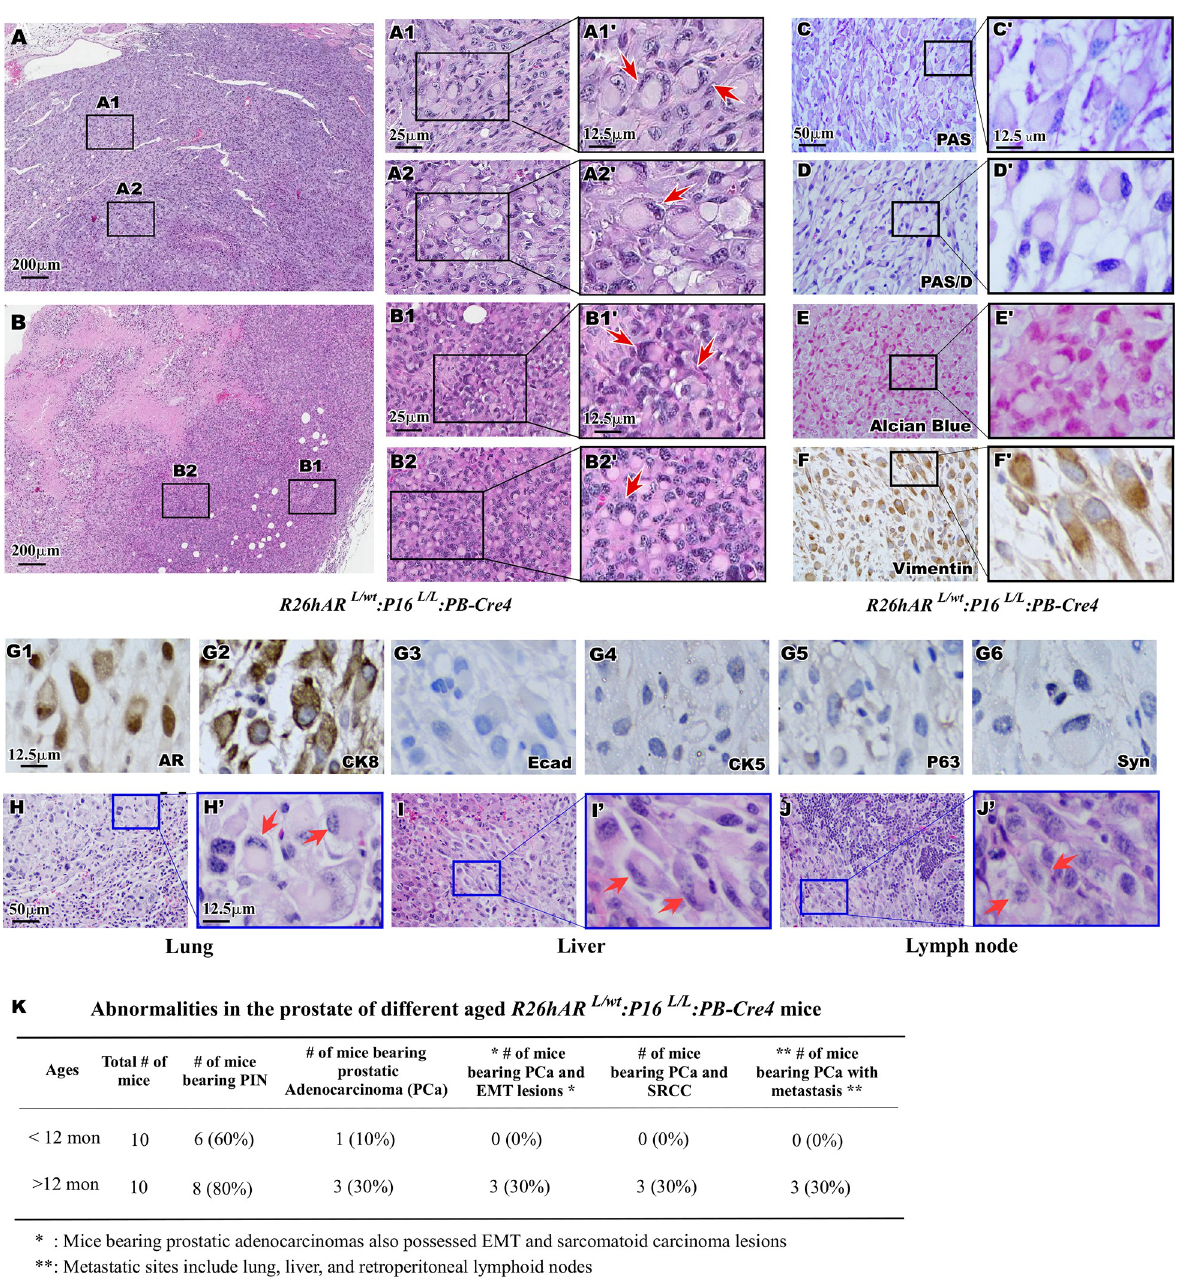
Fig 5. Histological and Immunochemical identification of signet ring cell carcinoma. (A-B) Representative image of the prostate signet ring cell carcinomas, SRCCs, in R26hAR L/wt : p16 L/L : PB-Cre4 mice. Scale bar = 200 μ m. A1-B2. Pathological characterization of typical morphological characteristics of SRCC was highlighted in two different tumor samples with magnified views (A1’- B2’). (C-F) Representative view is shown for PAS/PAS (C-D, magnified view C’-D’) staining, Alcian Blue staining (E, magnified view E’), and vimentin immunoreactivity (F, magnified view F’). Scale bar used was at 50 μ m and magnified views scale bar used was at 12.5 μ m. (G). Representative view of IHC images of adjacent prostate tissue sections of signet ring cell carcinoma lesion from the R26hAR L/wt : p16 L/L : PB-Cre4 mice are shown for staining with different antibodies (right bottom corner). Scale bar used was at 12.5 μ m. (H-J) Representative images of H&E of metastatic lesions in the lung (H), liver (I), and Lymph node (J) with magnified views (H’-J’). (K) Pathological abnormalities of the different aged mice were listed for R26hAR L/wt : p16 L/L : PB-Cre4 mice. Scale = 50 μ m, or 12.5 μ m (C-F,